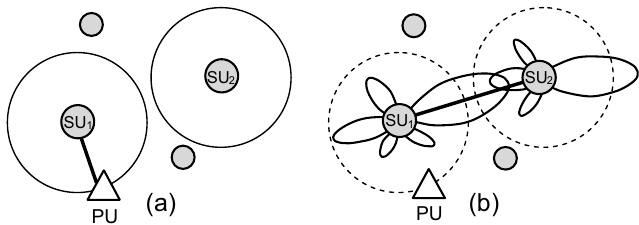
Figure 1. Difference in the network connectivity of CRAHNs with ( a ) omidirectional antenna and ( b ) directional